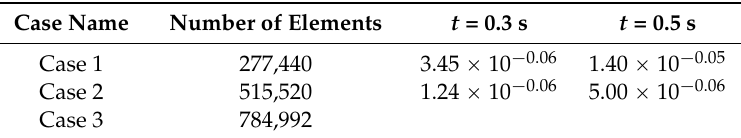
Table 3. Difference of maximum Von Mises strain between solution of Case 3 and two other cases ( (cid:1872) is time value).